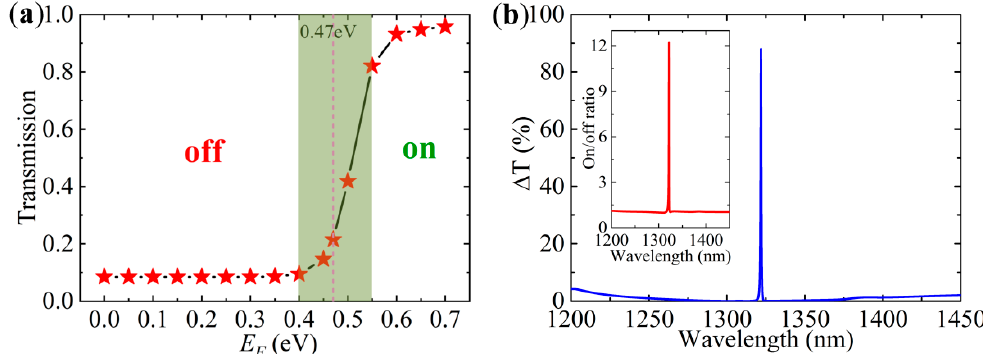
Figure 7. ( a ) The transmission at the EIT resonance as a function of the Fermi level. ( b ) Absolute value of the transmission difference as a function of the wavelength of the incident plane wave, and the inset is the on/off ratio.